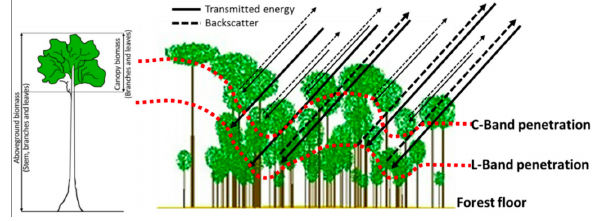
Figure 1. Location of the study area in Entre Rios, Argentina. The red frame is the approximate footprint of the SAR images, the blue-dotted rectangle indicates the areas for which field meas- urements were provided.